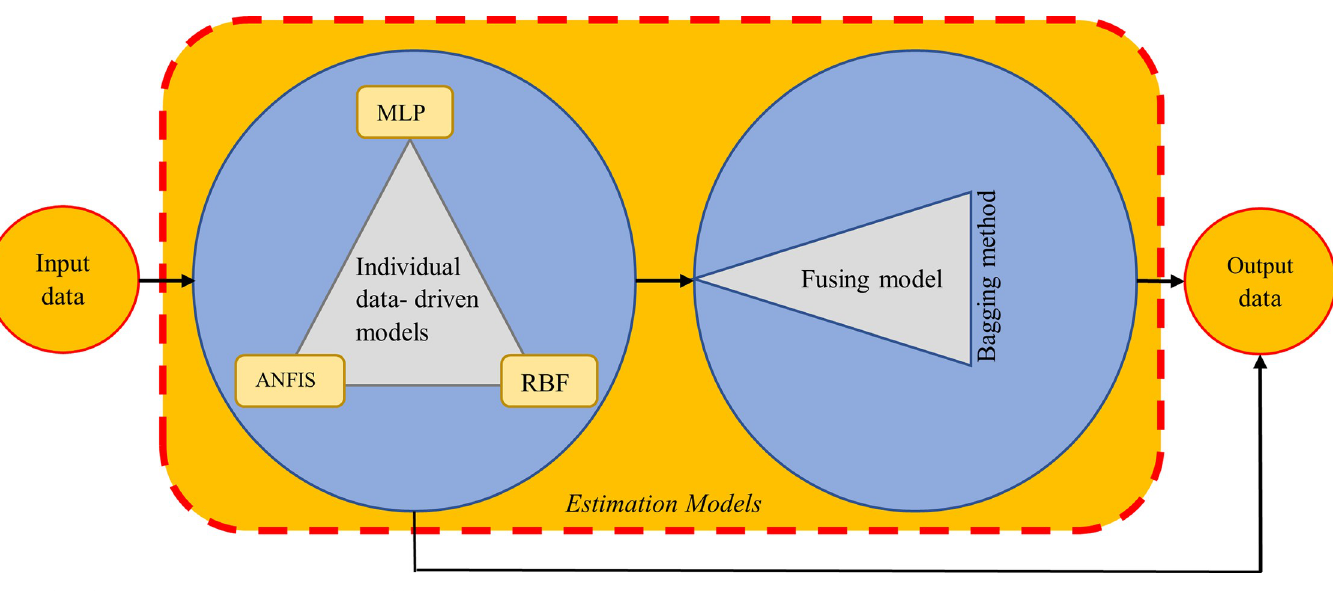
Fig 2. The schematic view of the proposed ensemble